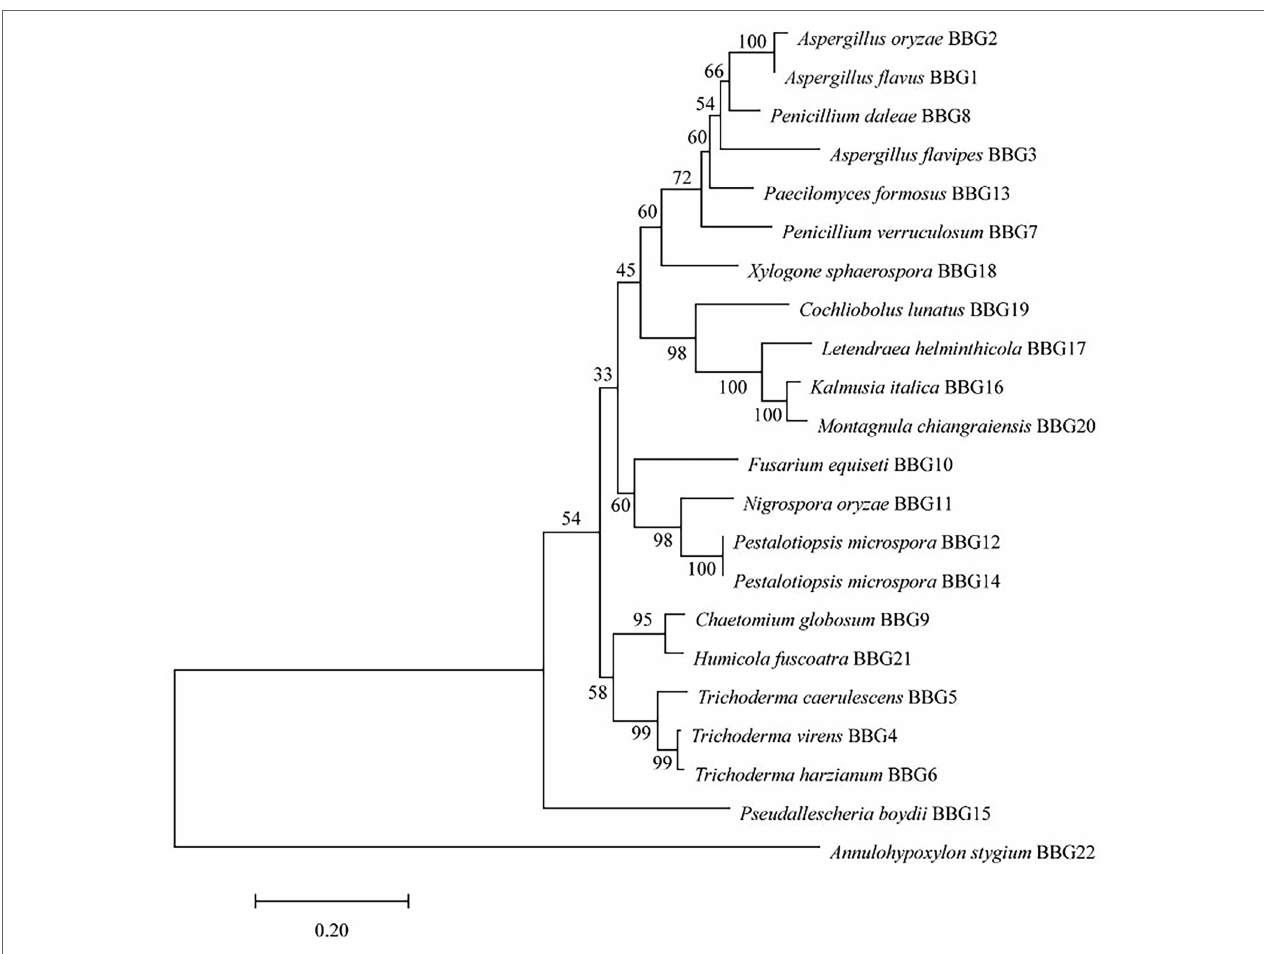
FIGURE 1 | Phylogenetic tree analysis of 22 marine fungal strains.